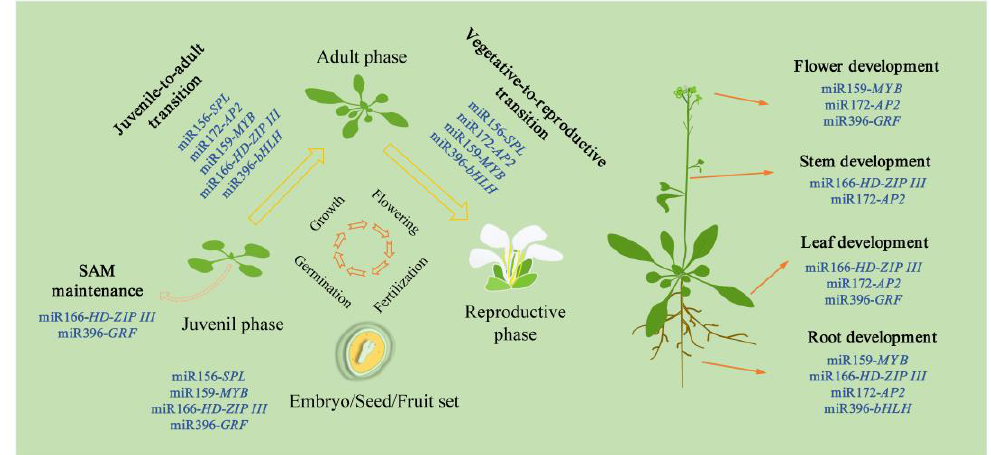
Figure 1. MiRNAs and their targets regulate the developmental phase transitions in plants. MiRNA-target modules not only regulate the juvenile-to-adult and vegetative-to-reproductive transitions, but also control the normal transitions within the formation of tissues / organs, including SAM, root, stem, leaf, flower and embryo / seed / fruit. The functions of the miRNAs, included in Figure 1, have been demonstrated in many plant species.